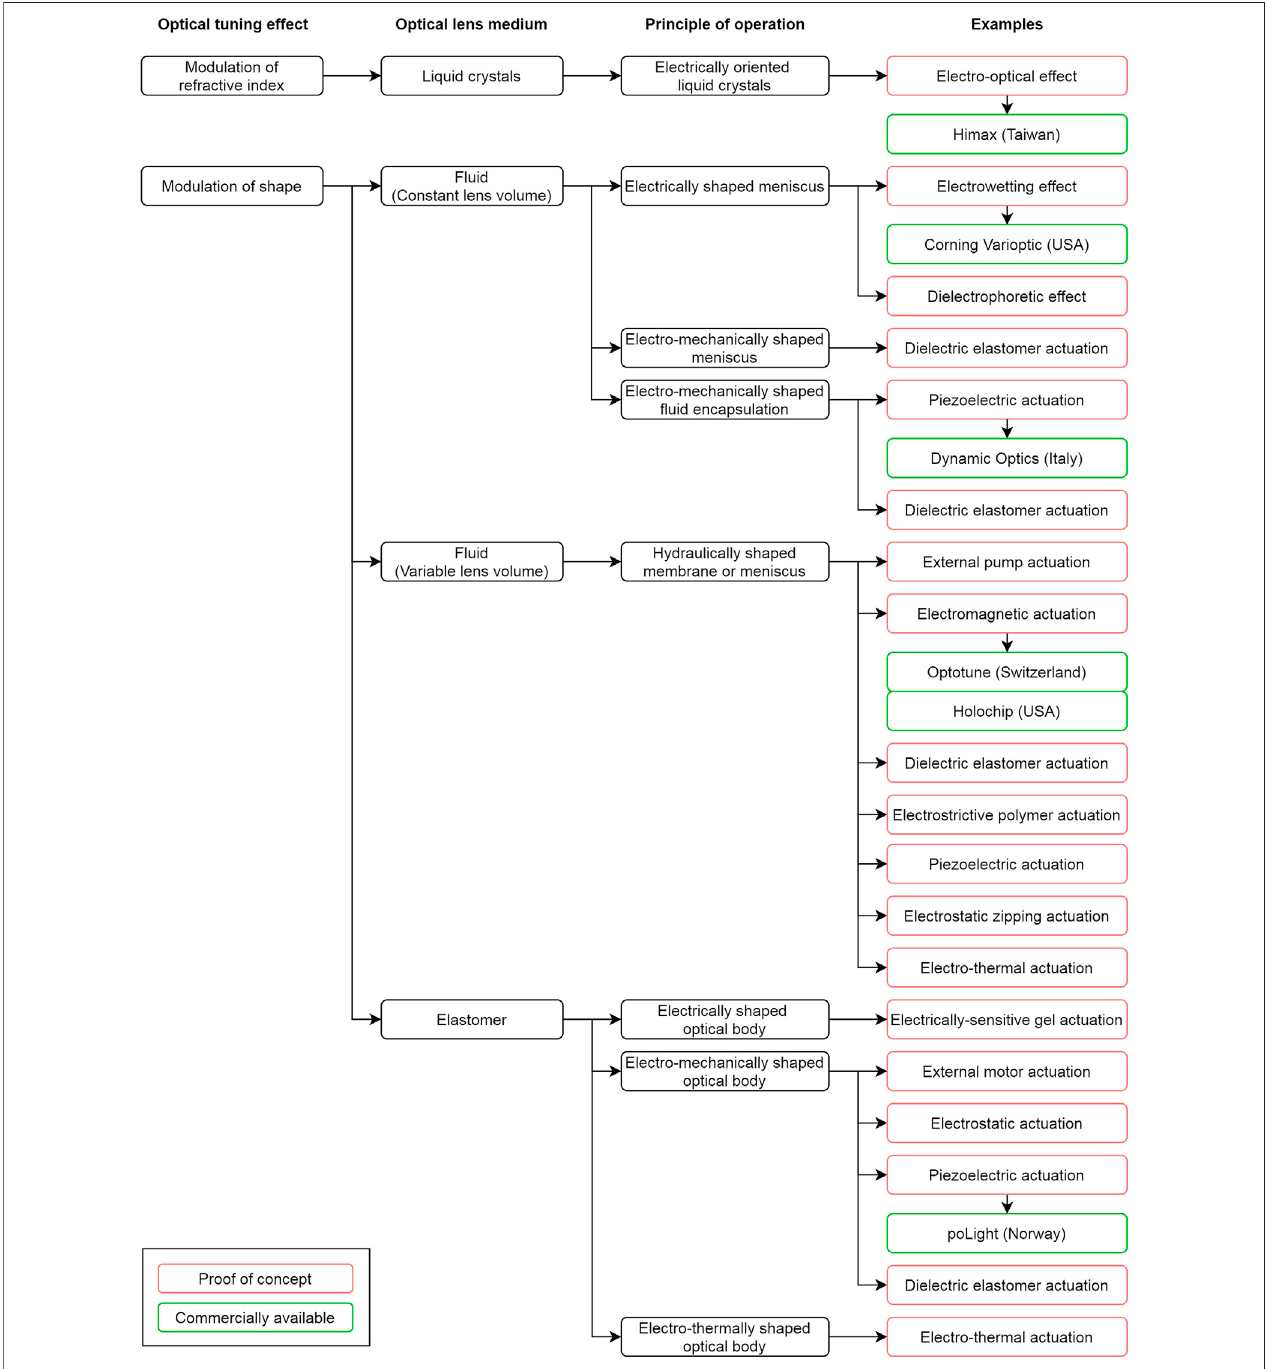
FIGURE1| Proposedclassi fi cationofelectricallytunablelensesoperatinginthevisiblerangeaccordingtoamodulationofeithertheirrefractiveindexortheirshape (surfacecurvature).Thisclassi fi cationintentionallycoversonlyprinciplesofoperationthatenableacontrollablefocusingofmulti-chromaticlight,withspatiallycontinuous (i.e. continuously tunable) wavefronts and focal